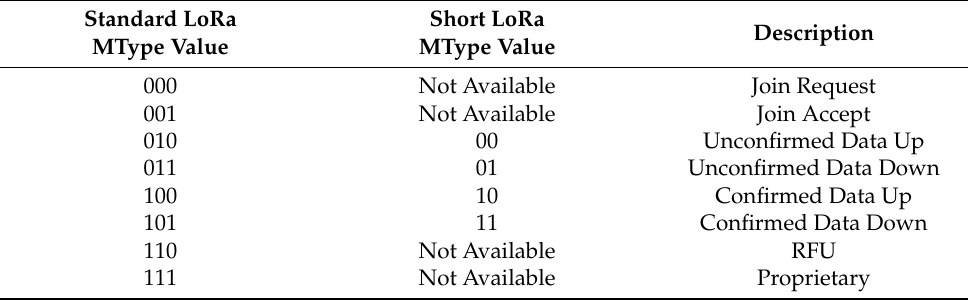
Table 4. Media Access Control (MAC) message